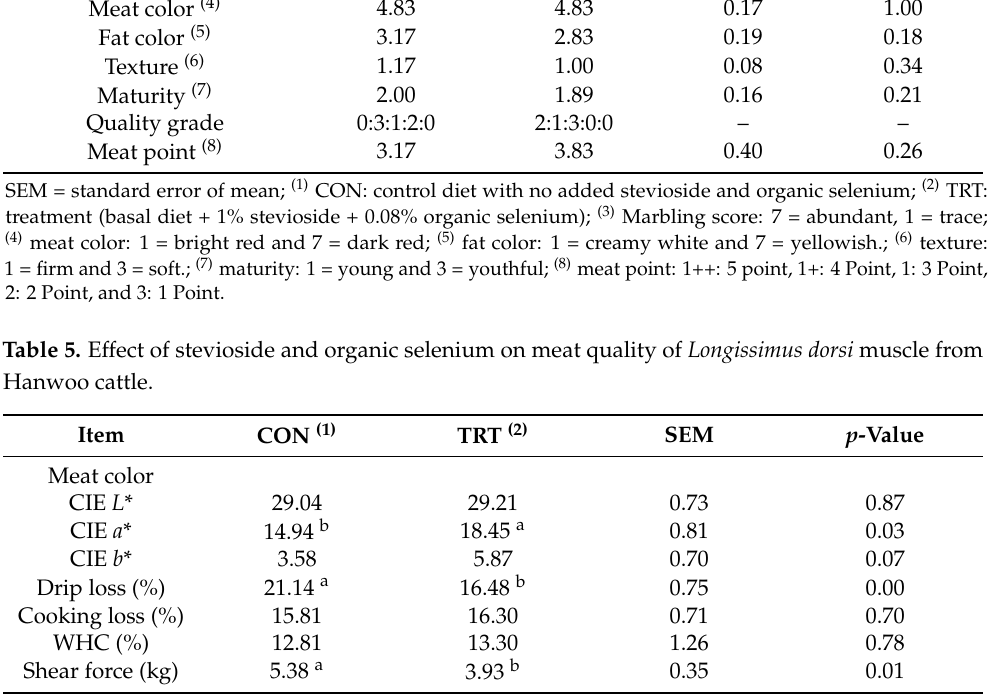
Figure 2. Effect of stevioside and organic selenium on the TBARS values in meats of Hanwoo cat- tle. Data presented as the mean ± s.e. bars at a specific time point with different letters show a sig- nificant difference ( p < 0.05). 3.5. Fatty Acid Analysis Monounsaturated fatty acids (MUFA) had the highest proportion. They constituted more than 50% of the total fatty acid composition, followed by saturated fatty acids (SFA) and polyunsaturated fatty acids (PUFA), accounting for 37–39% and 0.6–0.9%, respec- tively. Oleic acid (C8:1, 47%) was the predominant fatty acid among MUFA, followed by palmitoleic acid (C16:1, 5%), while palmitic acid (C16:0, 24–26%, stearic acid (C18:0, 8%) and myristic acid (C14:0, 3%) were predominant among SFA. On the other hand, the de- crease in SFAs content was not significant in the S- and O-Se-supplemented diet. Moreo- ver, the nervonic monounsaturated fatty acid content and linoleic, di homo-gamma lino- lenic, and arachidonic PUFAs contents were also higher in the animals fed the S- and O- Se-supplemented diet ( p < 0.05) (Table 6).